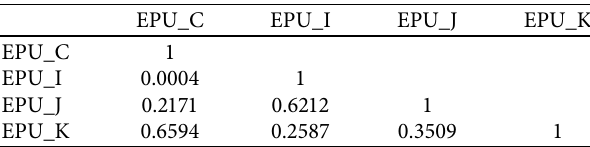
Table 2: Unconditional linear